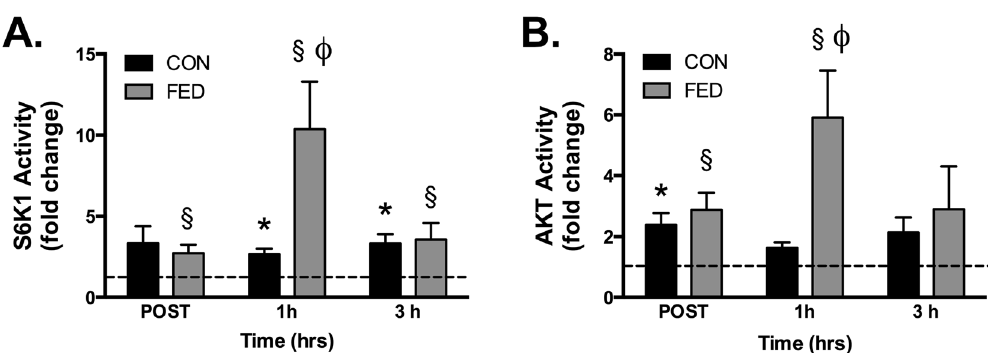
Figure 3. Post-exercise activation of S6K1 and AKT are augmented by PRO/CHO ingestion. Resistance exercise increased S6K1 activity, with this response significantly higher in the FED group 1 h post exercise ( A ). In parallel, AKT kinase activity was increased post exercise, with this response significantly higher in the FED group 1 h post exercise ( B ). Data presented as mean ± SEM (n = 7/group). * Significantly different to PRE-CON, § Significantly different to PRE-FED, Φ Significantly different to 1h-CON ( P <